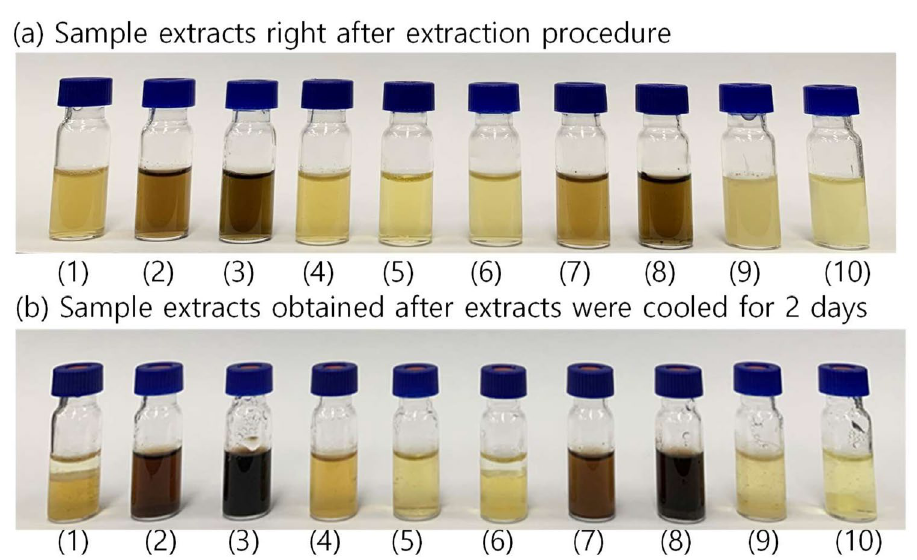
Figure 3. The sample extracts (a) right after the extraction was performed and (b) after the samples were stored at 4°C for 48 h. (1) DW (10 mL) and acidified MeCN (10 mL) with 100 µL formic acid (CH 2 O 2 ), (2) DW (15 mL) and acidified MeCN (5 mL) with 100 µL CH 2 O 2 , (3) DW (15 mL) and MeCN (5 mL), (4) acidified DW (15 mL) with 100 µL CH 2 O 2 and MeCN (5 mL), (5) acidified DW (10 mL) with 100 µL CH 2 O 2 and MeCN (10 mL), (6) DW (10 mL) and acidified MeOH (10 mL) with 100 µL CH 2 O 2 , (7) DW (15 mL) and acidified MeOH (5 mL) with 100 µL CH 2 O 2 , (8) DW (15 mL) and MeOH (5 mL), (9) acidified DW (15 mL) with 100 µL CH 2 O 2 and MeOH (5 mL), (10) acidified DW (10 mL) with 100 µL CH 2 O 2 and MeOH (10